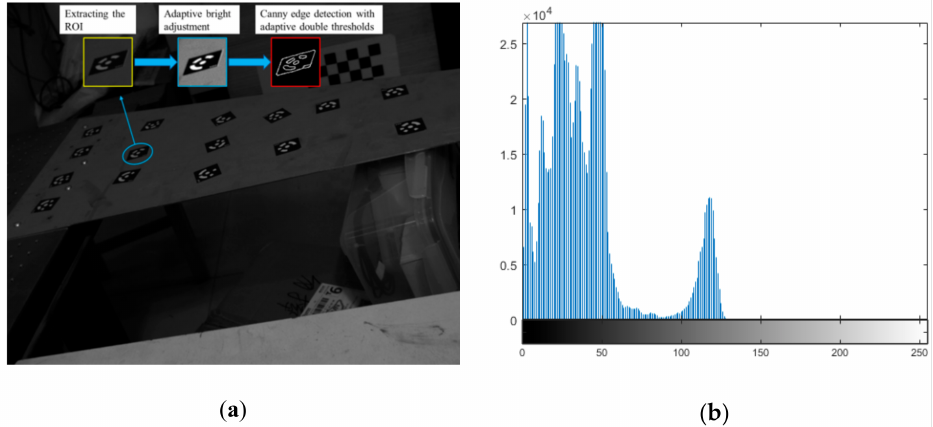
Figure 7. Result of adaptive Gamma correction: ( a ) Enhancing local image; ( b ) Histogram of original